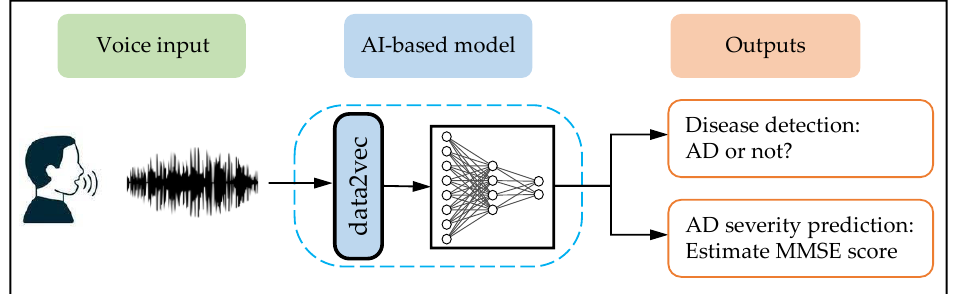
Figure 1. Overview of the AI-powered end-to-end model for AD diagnosis and disease severity prediction from voice. The system takes as input the voice recording from a subject that is converted into the embedding by data2vec, which is then fed into a neural network to determine the AD status and assess the severity of their AD in accordance with MMSE score.